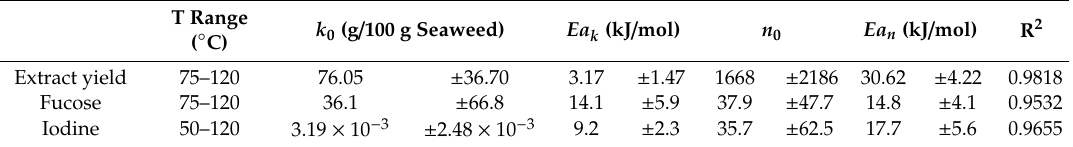
Table 1. Parameters and their standard deviations of power law and Arrhenius dependence applied to iodine, fucose, and crude extract yield